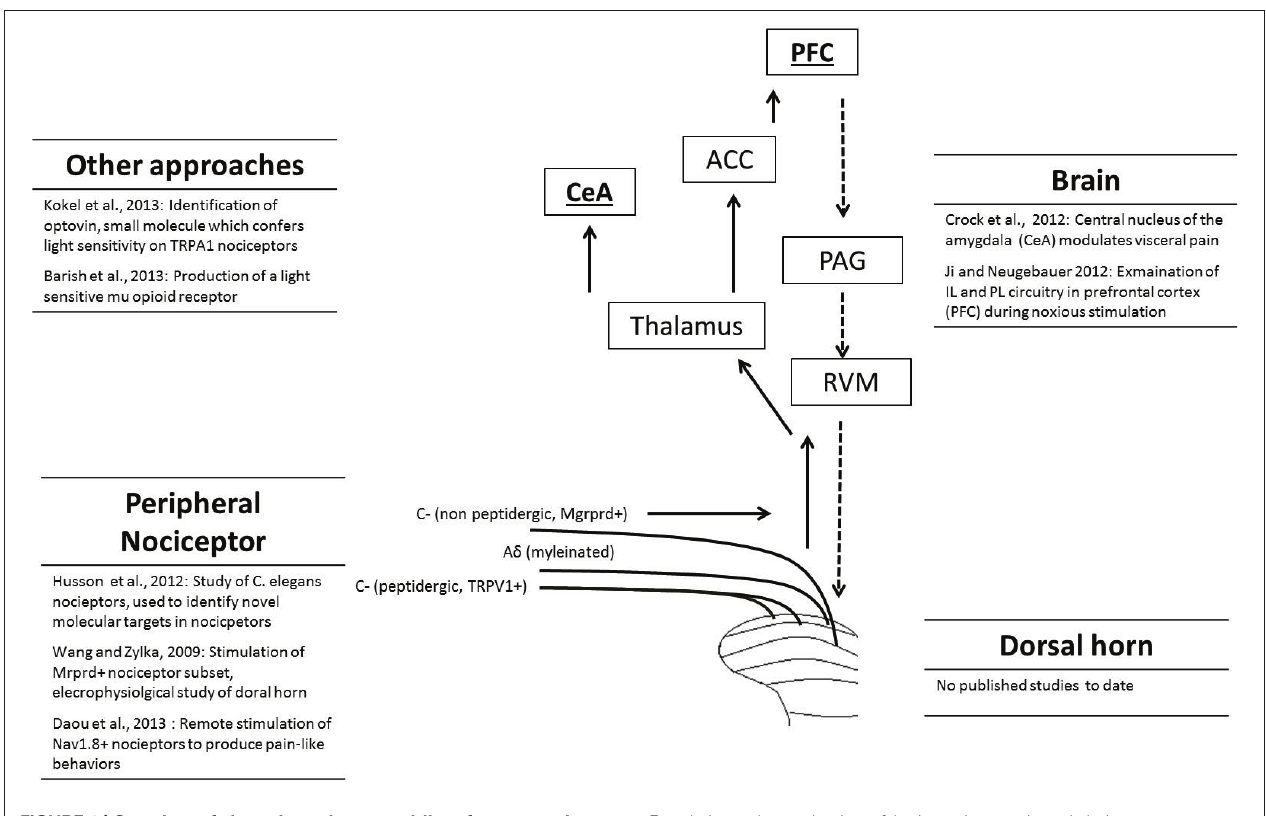
FIGURE 1 | Overview of the pain pathway, and list of optogenetic studies to date that have targeted each level . The full arrows indicate the ascending pain pathway, while the descending pathway is represented by dashed arrows. Different categories of nociceptor, including unmyelinated C-fibers and myelinated A δ -fibers are shown.